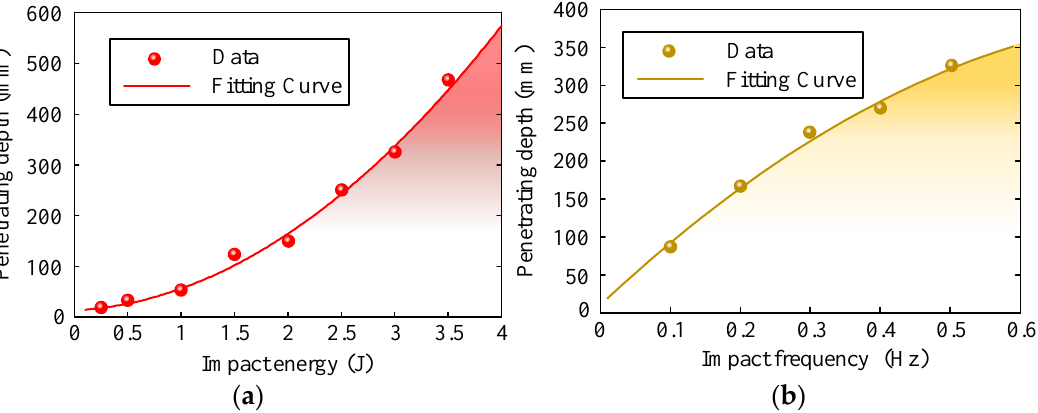
Figure 11. The relationship between the penetrating depth and impact energy and impact frequency: ( a ) penetrating depth varies with impact energy when impact frequency is 0.02 Hz; ( b ) penetrating depth varies with impact frequency when the impact energy is 1.5 J.